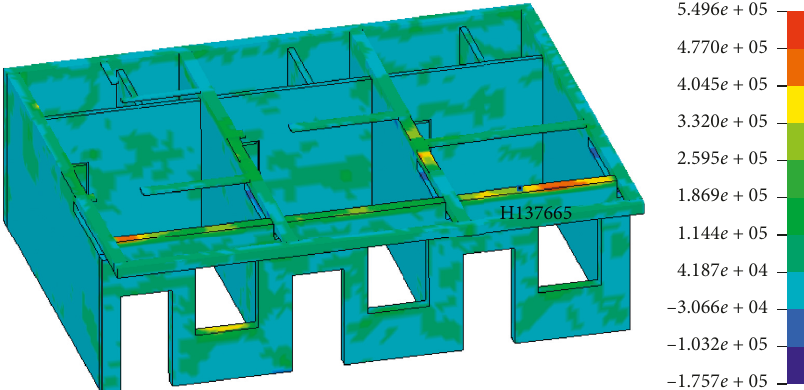
Figure 24: PTS contour on the first floor cross section ( t � 0.101s) [13] (unit: